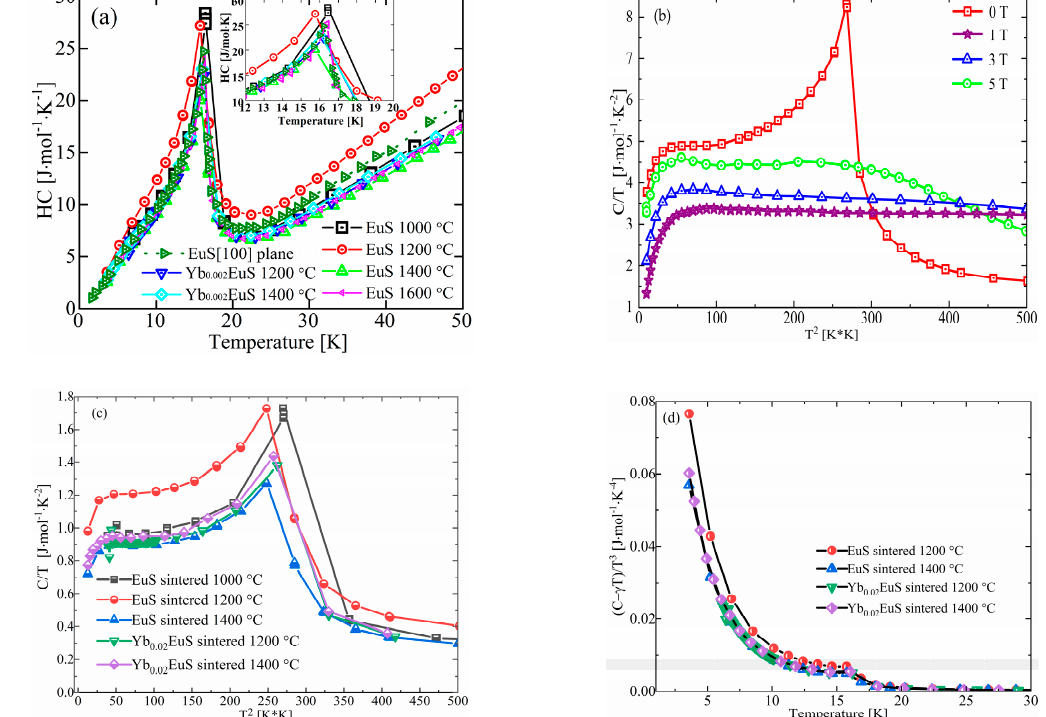
Figure 5. Temperature dependences of the specific heat, C(T), of Yb-doped EuS and undoped EuS [13] ( a ); plots of C/T vs. T 2 for EuS ( b ) and Yb-doped EuS ( c ); the temperature dependence of (C − γ T)/T 3 ( d ).